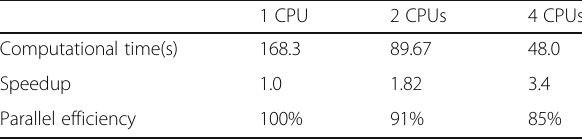
Table 3 Computational time, speedup, and parallel efficiency